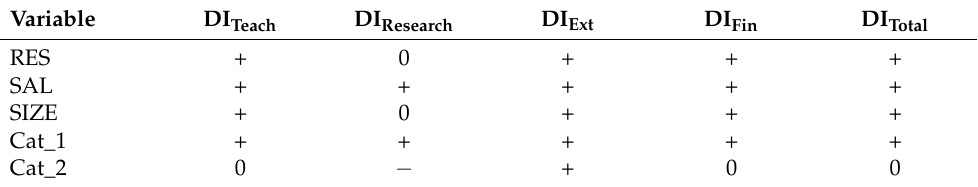
Table 9. Variables’ influence over the level of performance-reporting disclosure index.